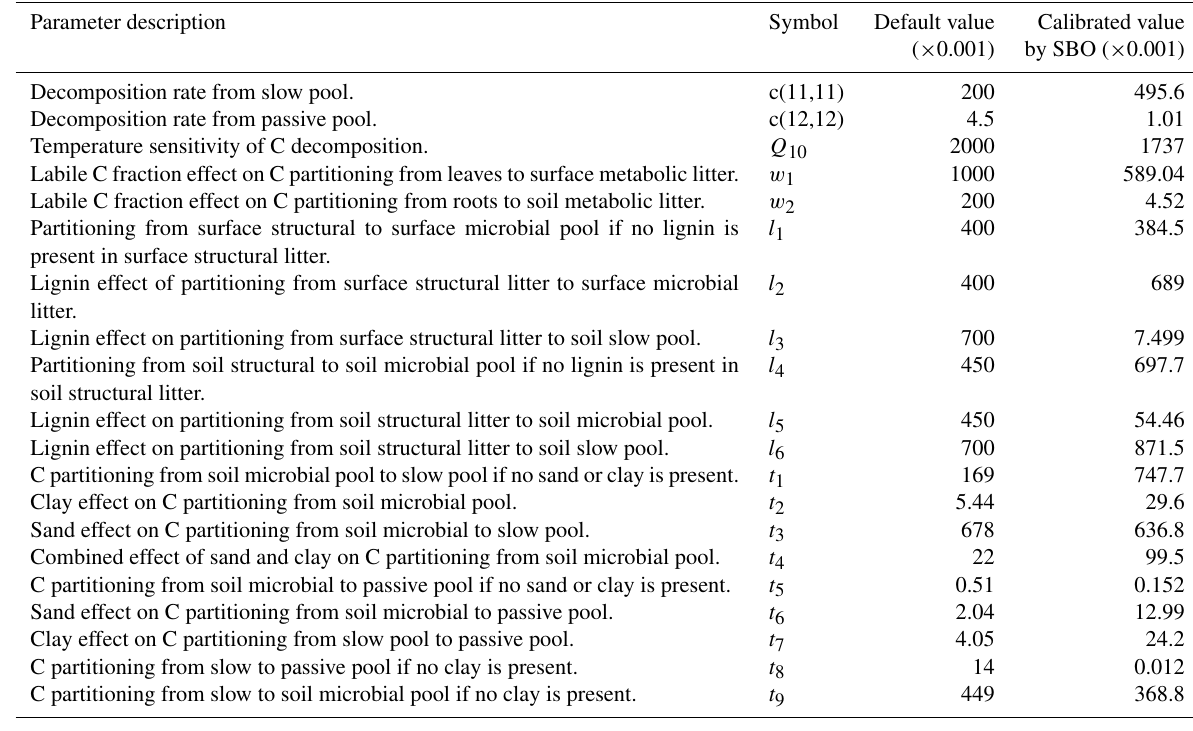
Table 1. Parameter description of CLM-CASA’ C-only model. Parameter description Symbol Default value Calibrated value Decomposition rate from slow pool. Decomposition rate from passive pool. Temperature sensitivity of C decomposition. Labile C fraction effect on C partitioning from leaves to surface metabolic litter.